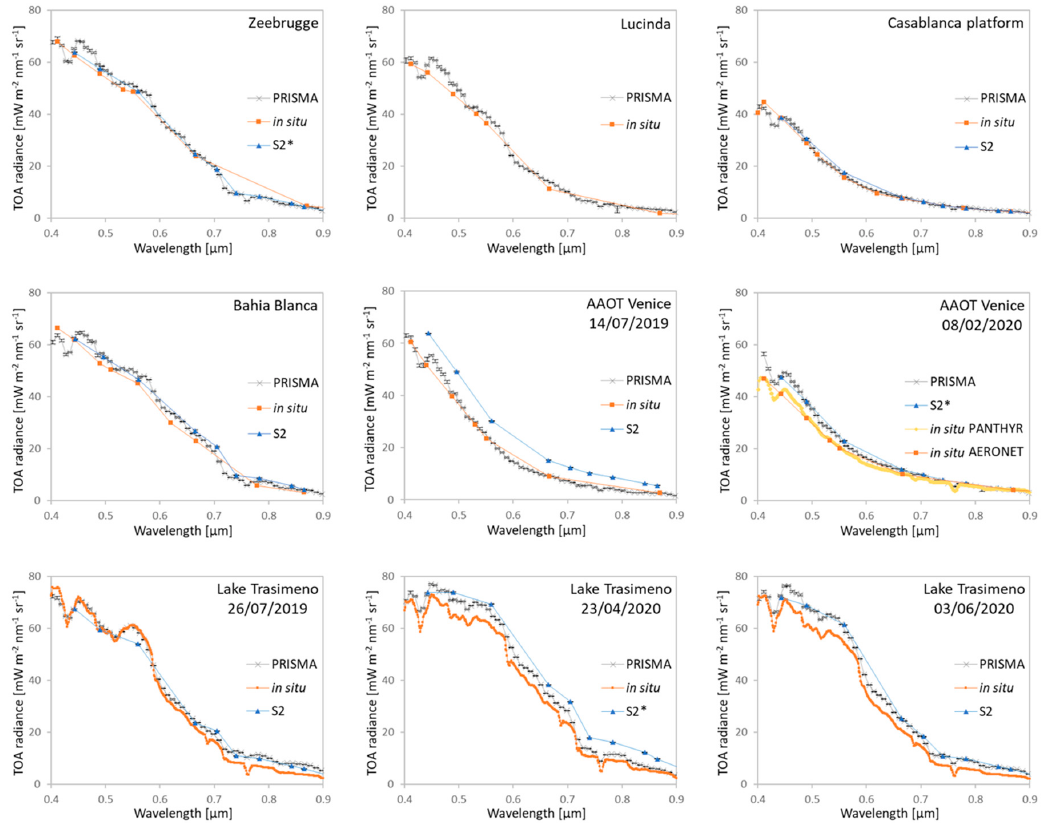
Figure 2. TOA radiances measured by PRISMA and Sentinel-2/MSI (S2), and simulated with 6SV (labelled as in situ). Symbol * means that Sentinel-2 and PRISMA overpasses occurred on the same day. The image-by-image comparison of PRISMA with 6SV simulations (Figure 3) shows a R 2 of about 0.99 indicating a strong linear correlation in the VNIR range. RMSDs is